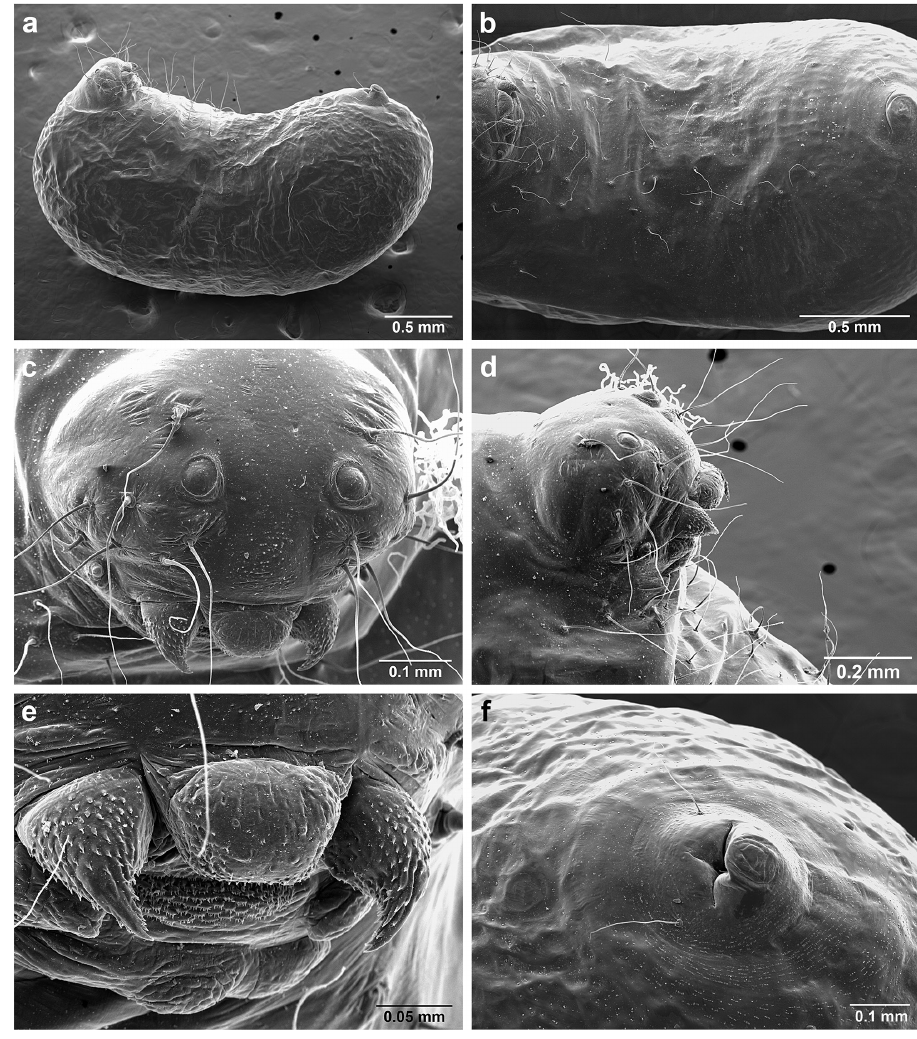
Figure 40. S. mayri larva (USNMENT01126227: a, f USNMENT01126230: b, c, d, e ), SEM images. a Lateral view b ventral view c head, frontodorsal view d head, lateral view; e mouthparts f anal